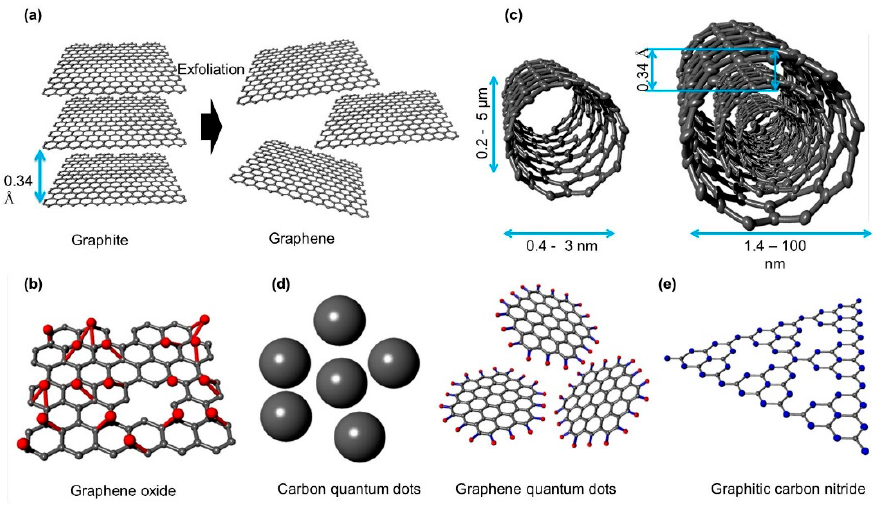
Figure 2. Structure of carbon materials ( a ) graphene, ( b ) graphene oxide (GO), ( c ) single-wall and multiple-wall carbon nanotubes, ( d ) carbon quantum dots and graphene quantum dots, and ( e ) graphitic carbon nitride.